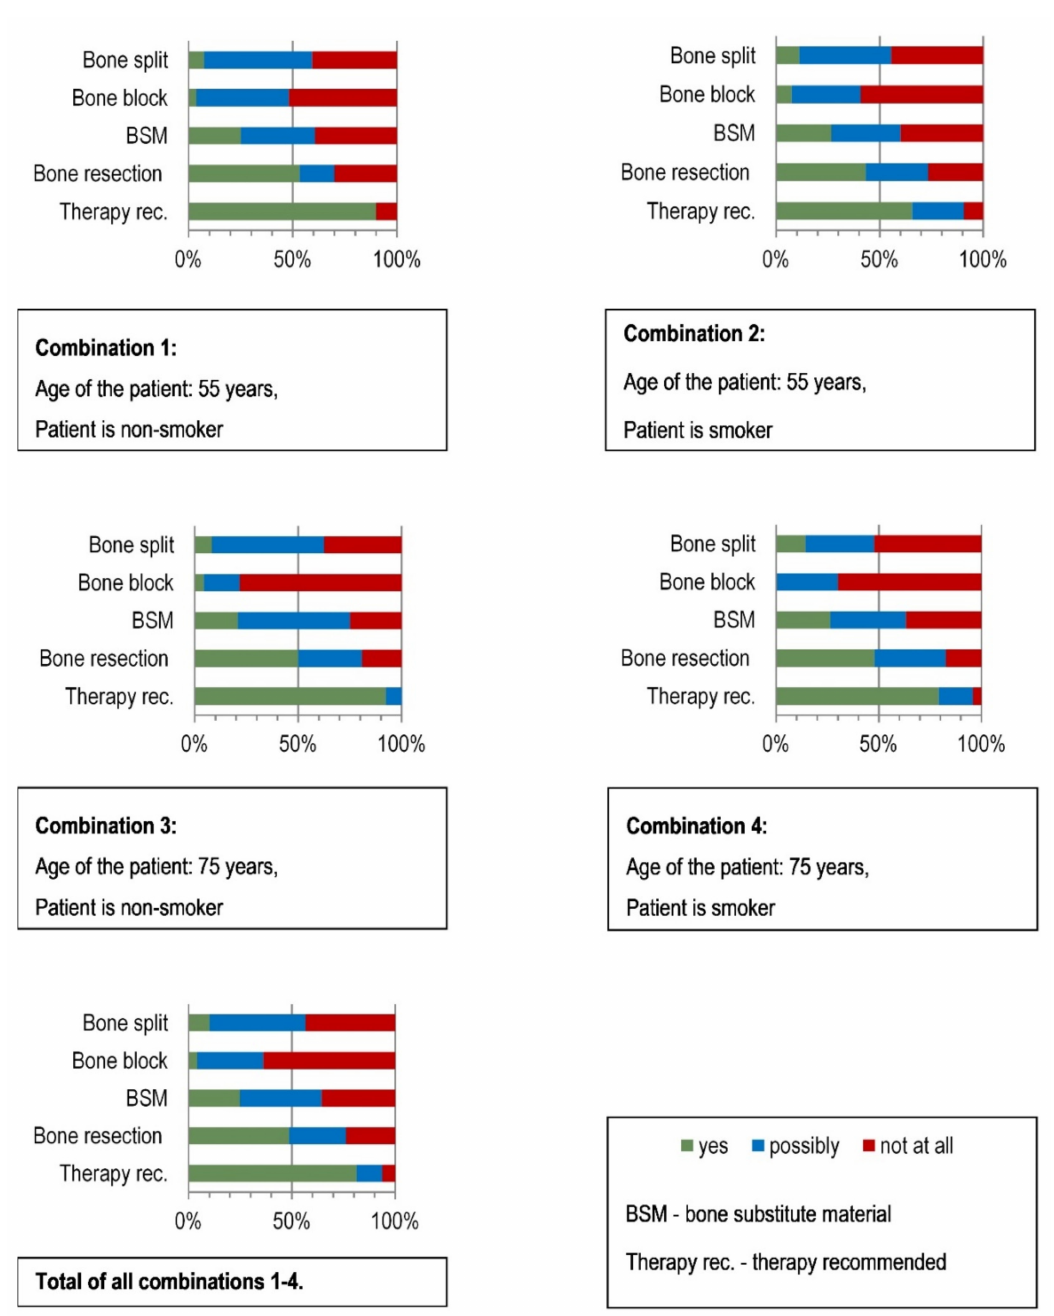
Figure 5. Preferred therapy decisions of the surgeons surveyed for the restoration of the edentulous severely atrophied mandible according to the four different combinations of “patient age” and “smoking”. Case Vignette